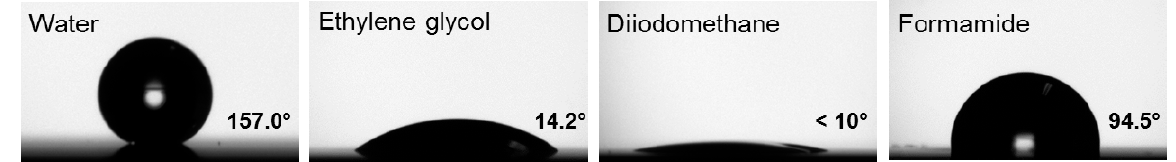
Figure 8. Images of a liquid droplet on MacroPSi-2 with a porosity of 86.2 ± 6.2%. After chemical modification with FOTS, all the contact angle values increased, as we expected. The wettability of the surface changes from hydrophobic to superhydrophobic for water and from olehophilic to oleophobic for the probe liquids with low surface tension. In this case, the topography is not decisive. If we compare samples with different porosities, the CA value increases slightly higher when the porosity increases, but it is not a significant value (Table 5). Table 5. Summary of contact angle values for MacroPSi substrates after FOTS modification using different solvents. Substrates